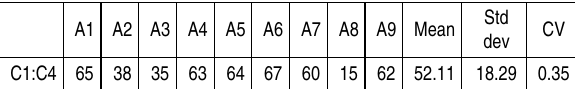
Table 33. Consortium C1:C4